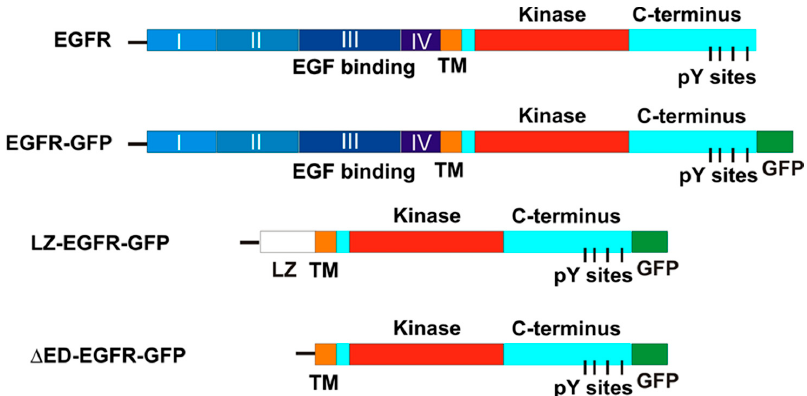
Figure 1. Schematic illustration of EGFR-GFP, LZ-EGFR-GFP and Δ ED-(extracellular-domain deleted)-EGFR-GFP as compared to wild type EGFR (wtEGFR). The chimeric construct LZ-EGFR-GFP started with the signal sequence of wtEGFR (line), followed by a LZ sequence that replaced the complete extracellular domain of EGFR. Δ ED-EGFR-GFP is a truncated EGFR with the deletion of its entire extracellular domain. The green fluorescent protein (GFP) is tagged to the C-terminus of EGFR.